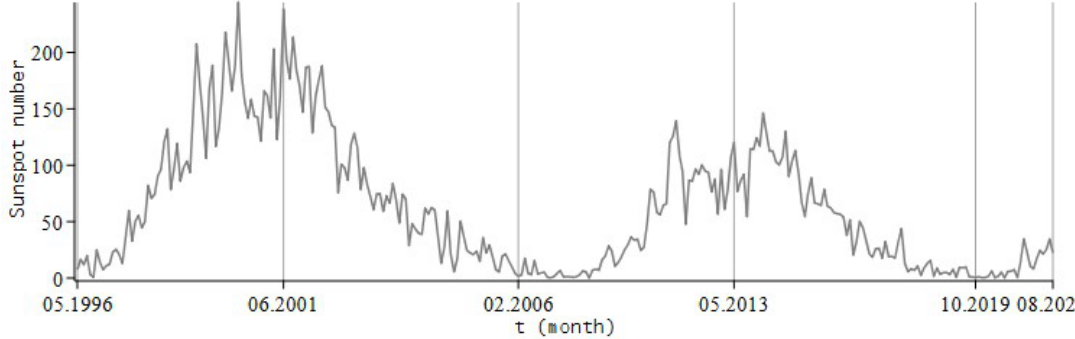
Figure 9. Monthly sunspot data from May 1996 to August 2021 in 1-month